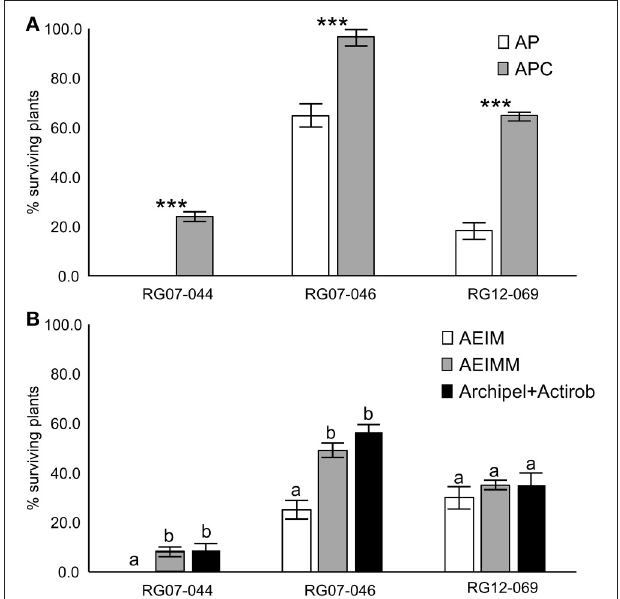
FIGURE 2 | Frequencies of resistant plants in the three rye-grass populations studied. (A) Frequencies of resistant plants in the three rye-grass populations studied observed after the application of pyroxsulam + Actirob (AP, white bars) or pyroxsulam + cloquintocet-mexyl + Actirob (APC, gray bars). ***Indicate significant differences in the number of resistant plants between experimental modalities within each population according to Fisher’s exact test ( p < 0.001). (B) Frequencies of resistant plants in the three rye-grass populations studied observed after the application of iodosulfuron + mesosulfuron in ethoxylated castor oil + Actirob (AEIM, white bars), iodosulfuron + mesosulfuron + mefenpyr-diethyl in ethoxylated castor oil + Actirob (AEIMM, gray bars) and the commercial herbicide Archipel + Actirob (Archipel + Actirob, black bars). Different letters among experimental modalities within one population indicate significant differences in the number of resistant plants according to Fisher’s exact test ( p < 0.05).